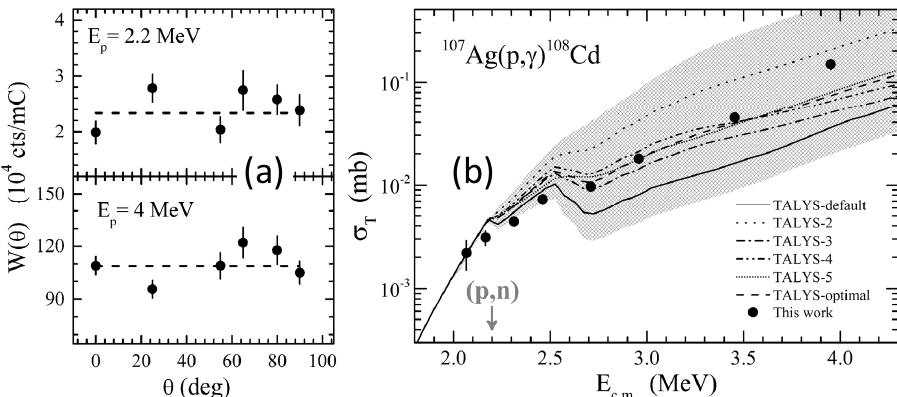
Figure 3. Panel (a): Typical angular distributions of the 633-keV 2 + 1 → 0 + 1 transition of 108 Cd obtained at the lowest (2.2 MeV) and highest (4 MeV) proton beam energies measured. The dashed curves indi- cate the average value of the data points, which was used to derive the cross section at the corresponing beam energies as descussed in [11]. Panel (b): Comparison of the experimental cross sections (black solid circles) of the 107 Ag( p, γ ) 108 Cd reaction with TALYS calculations. Details are given in section